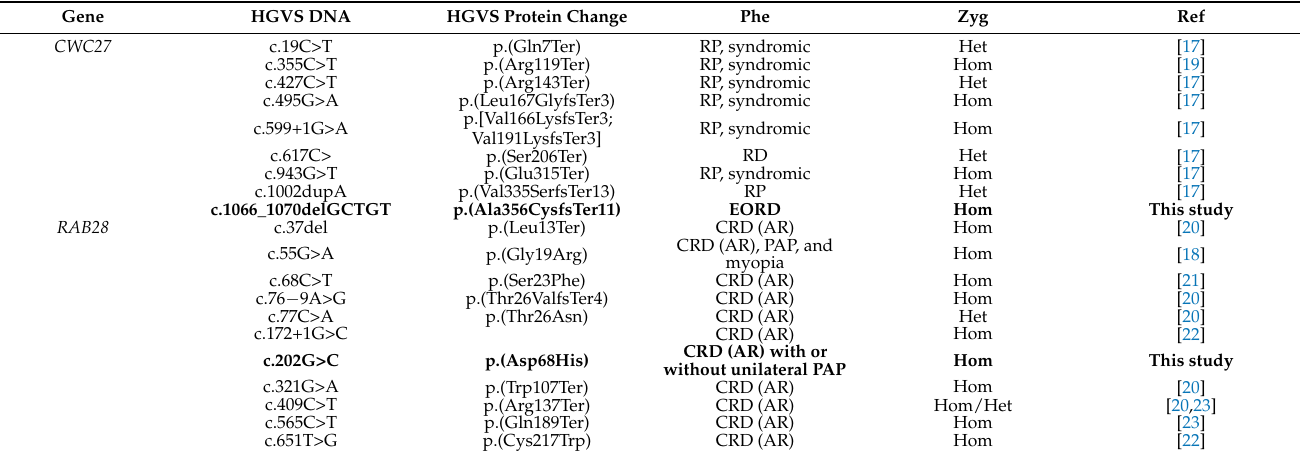
Figure 2. Clinical features of patients with CWC27 and RAB28 mutations. ( A ) Patient 51. Fundus photograph and full field electroretinography (ffERG) images (OU). Pale optic disc, attenuated retinal blood vessels and atrophy of retinal pigment epithelium around the vascular arcades. The ffERG demonstrated no response of rods and reduced response of cones. These images were taken when the patient was 16 years old; ( B ) Patient 70. Fundus photograph and optical coherence tomography (OCT) images (OU): Temporal pallor of the optic disc, attenuated retinal arteries and retinal pigment epithelium atrophy in OD. Pale optic disc, colobomatous-like lesion in the macula with hyperpigmented edges; sclera visible and choroidal vessels in OS. The OCT demonstrated macular thinning with atrophy and loss of the outer layers of the entire central zone in OD; colobomatous-like lesion, chorioretinal atrophy and loss of outer layers and choroid in OS. Postaxial polydactyly in right foot (red arrow); ( C ) Patient 71. Fundus photograph, fundus autofluorescence and OCT images (OU). Temporal pallor of the optic disc, mild peripapillary atrophy, hypopigmented lesion in the macula area in OD. Peripapillary atrophy, attenuated retinal blood vessels and hyperpigmented lesion in central area in OS. AF showing macula with central hypoautofluorescence, a ring surrounded by hyperautofluorescence and external hypoautofluorescence; atrophy of retinal pigment epithelium outside the arcades. The OCT demonstrated loss of photoreceptor layer in the central area with pigment epithelium atrophy. Normal feet. OD: oculus dexter (right eye); OS: oculus sinister (left eye); OU: oculus uterque (both eyes). Table 4. Mutations associated with IRDs in the CWC27 and RAB28